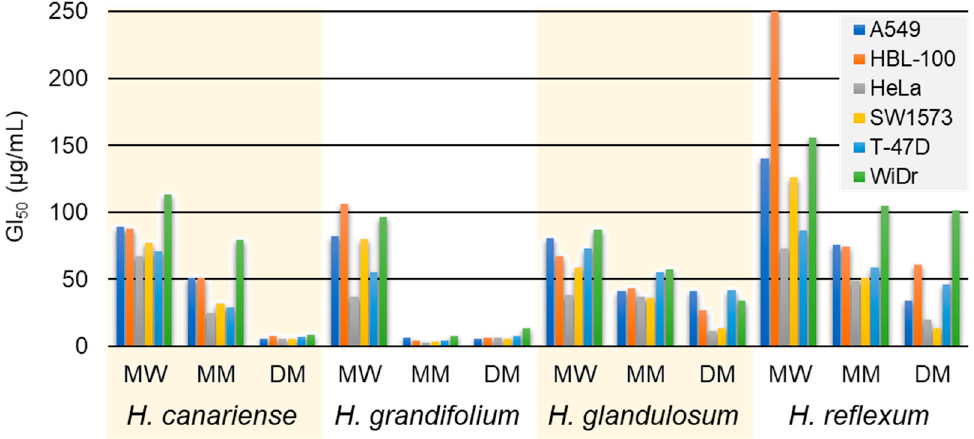
Figure 2. Antiproliferative activity (GI 50 ) of microextracts from Hypericum species. MW = methanol– water; MM = methanol; DM = dichloromethane–methanol.